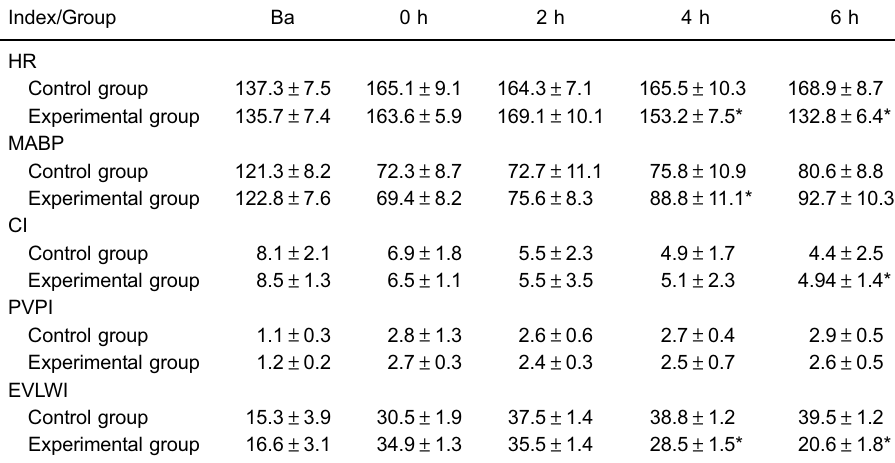
Table 2. Changes of hemodynamic indexes of male pigs induced with acute respiratory distress syndrome that received continuous veno-venous hemo fi ltration therapy (experimental) or conventional supportive therapy (control).